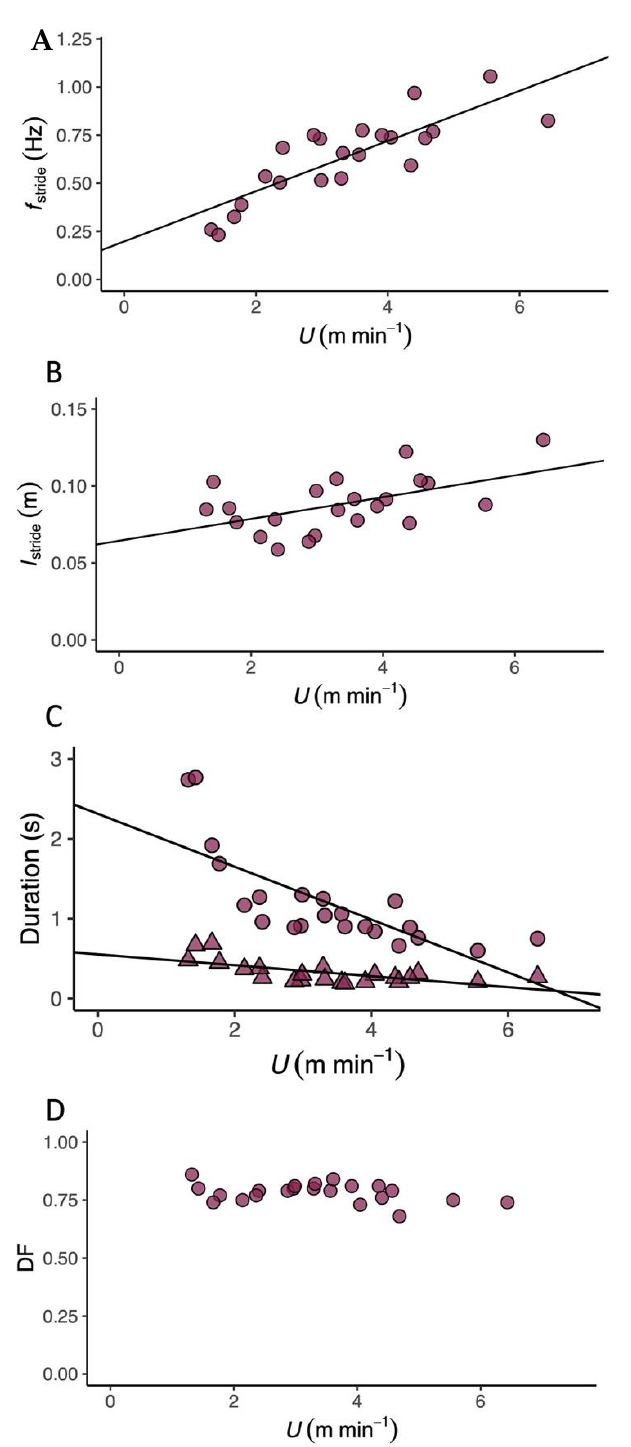
Figure 3. Locomotor kinematics in the Mediterranean spur-thighed tortoise ( T.graeca ). ( A ) Stride frequency ( f s tride , Hz, circles) increased linearly with increasing speed ( U , m min − 1 ). ( B ) Stride length ( l stride , m, circles) also increased linearly with increasing U . ( C ) Swing ( t swing , triangles) and stance ( t stance , circles) durations (s) both decreased linearly with increasing U. t stance was always greater than t swing . ( D ) Duty factor (DF, circles) was not affected by U . The lines of best fit and associated statistical output are presented in Table 1.